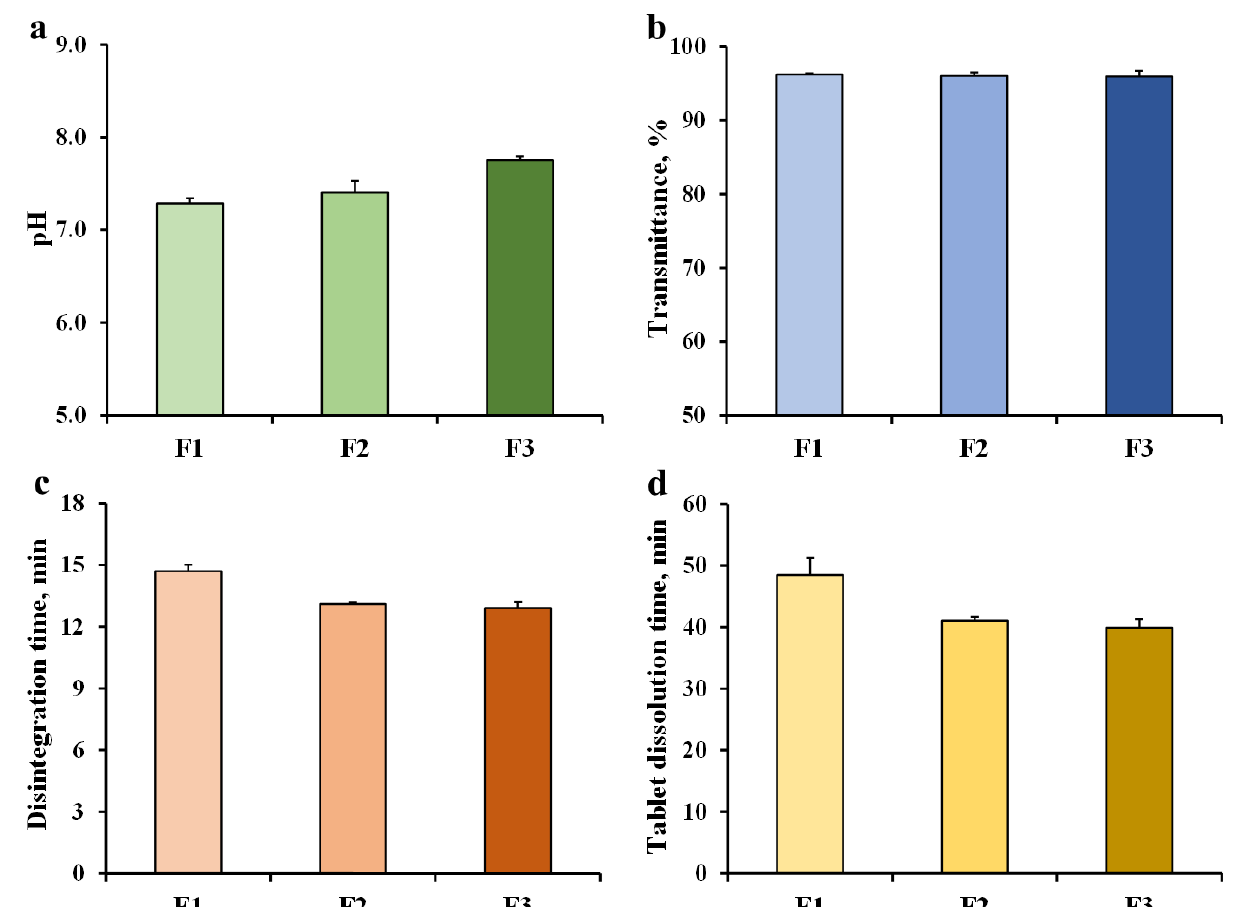
Figure 2. Effect of buffering agents on pH ( a ) and % transmittance ( b ) of fluconazole mixtures, disintegration time ( c ), and tablet dissolution time ( d ) of fluconazole tablets. Each value is the mean ± S.D., n = 3.